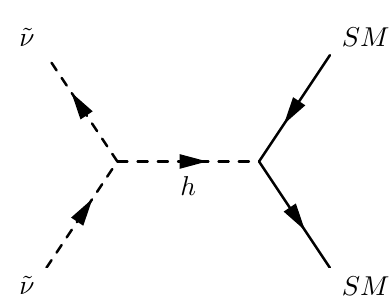
Figure 1 . Dominant DM annihilation process for scenarios where the sneutrino is the LSP. The (cid:12)nal state generically denotes any SM particle the Higgs boson couples